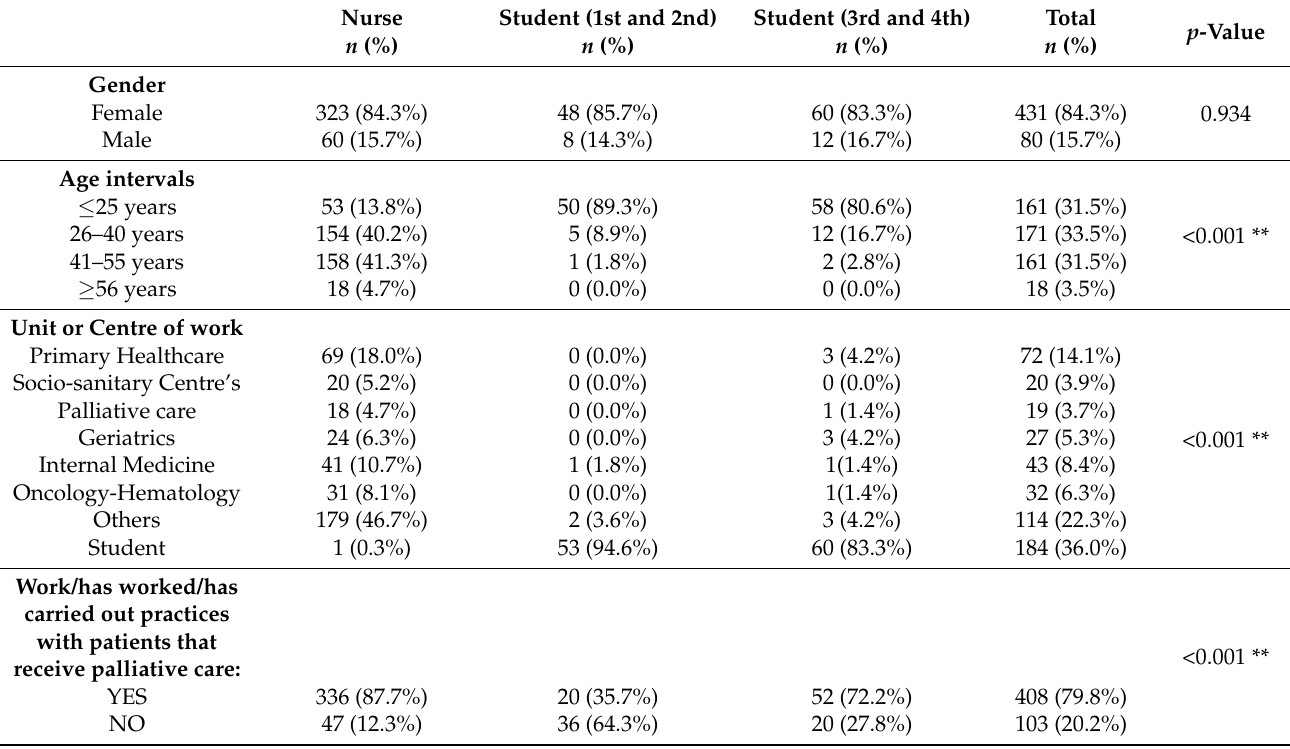
Table 1. Socio-demographics variables.